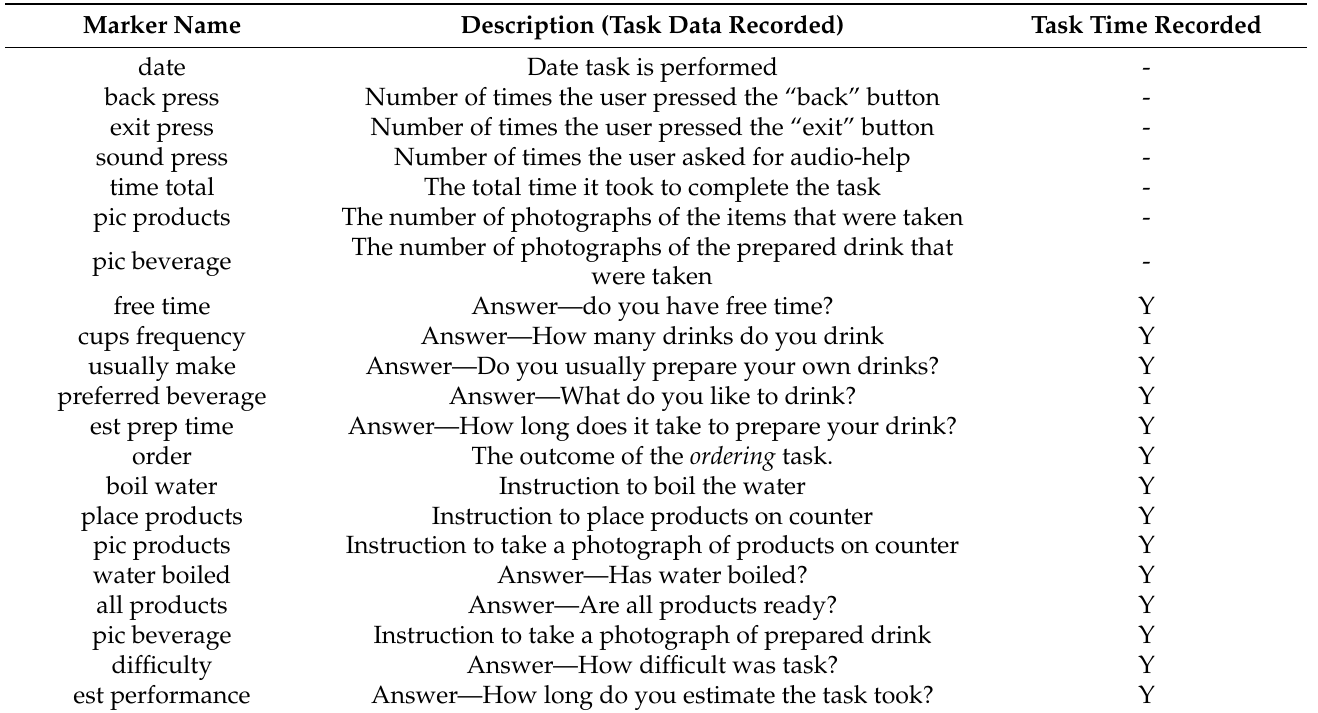
Table 1. Recorded data and